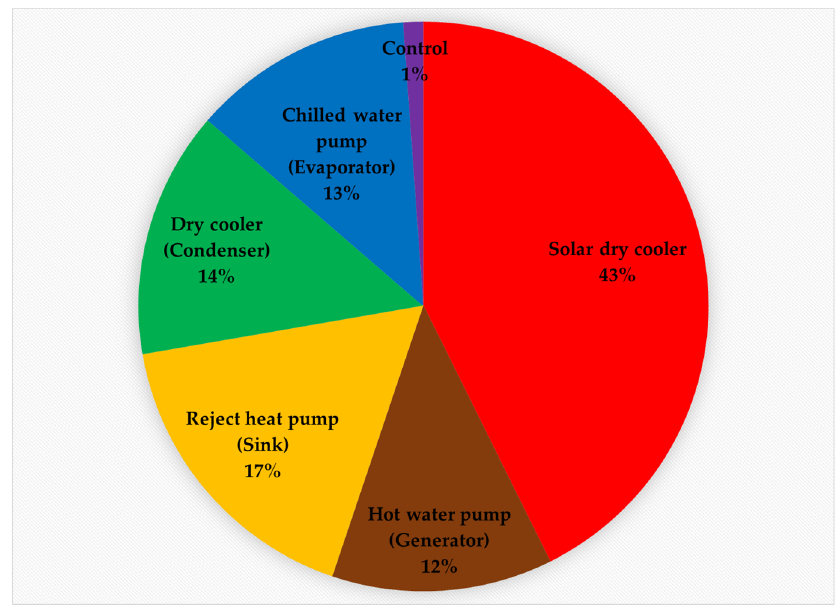
Figure 9. Percentage share of the auxiliary power consumption components of the absorption system.